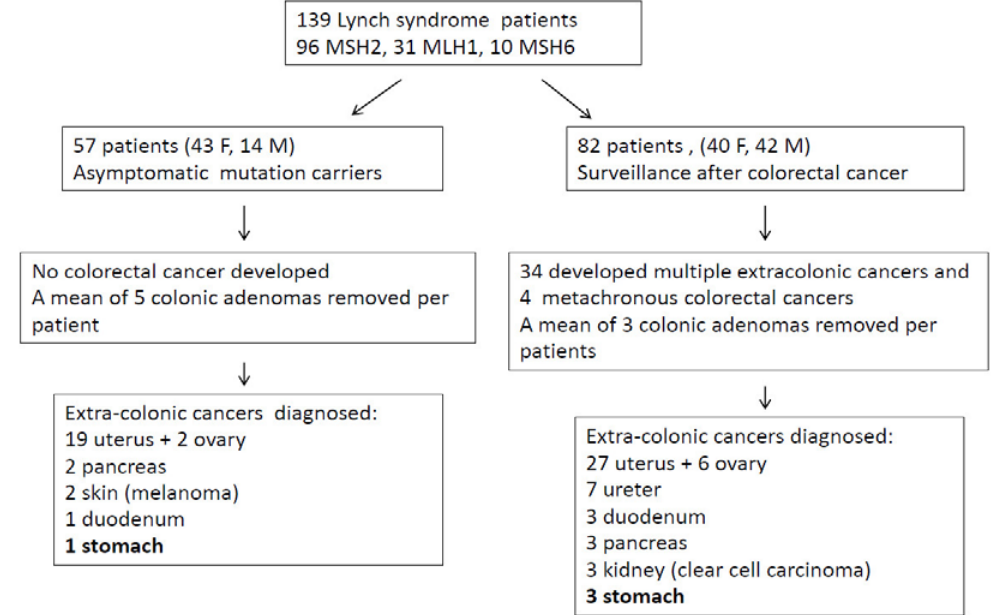
Figure 7. Lynch syndrome patients and cancer registered.